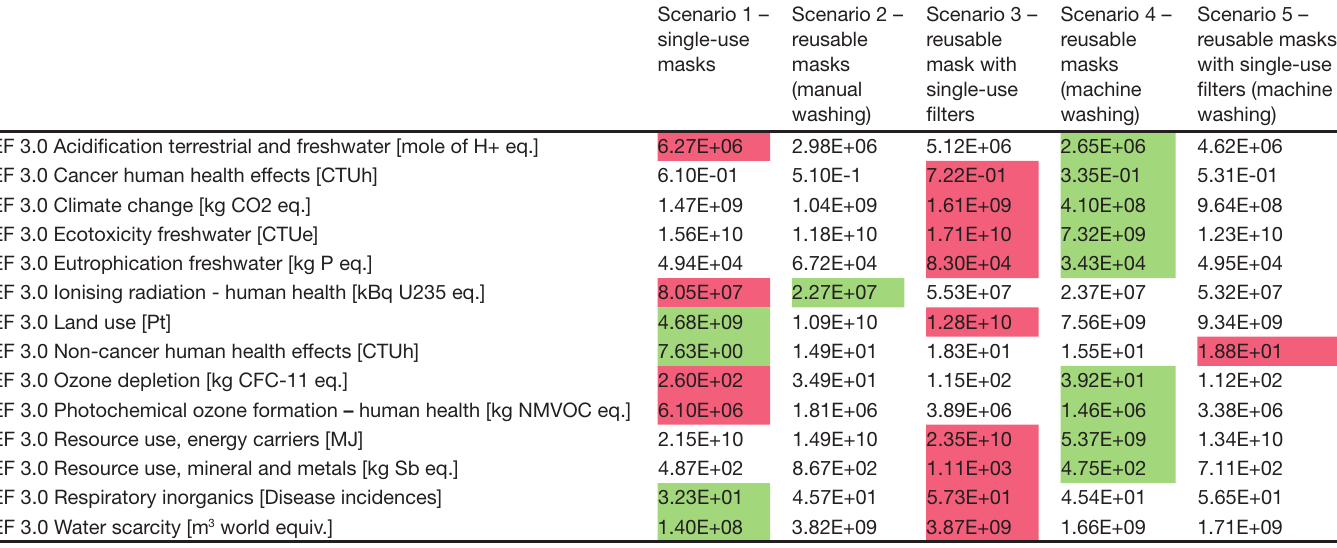
Table A11. Overall environmental impact results for each face mask scenario.